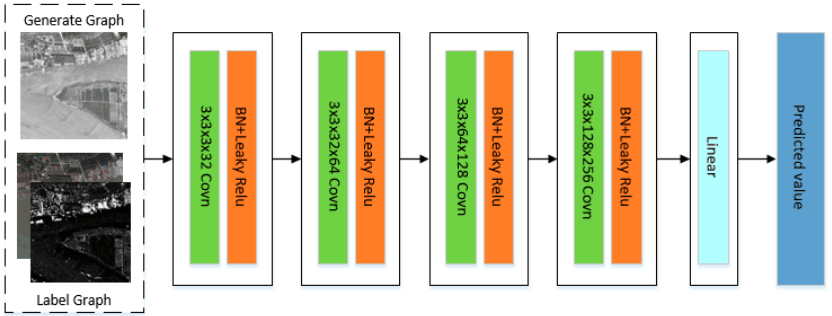
Figure 4. Network architecture of discriminator.